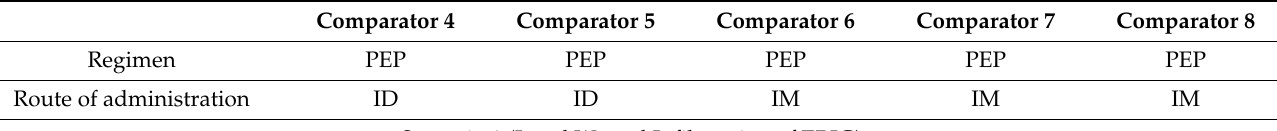
Table 4. Results of Scenario